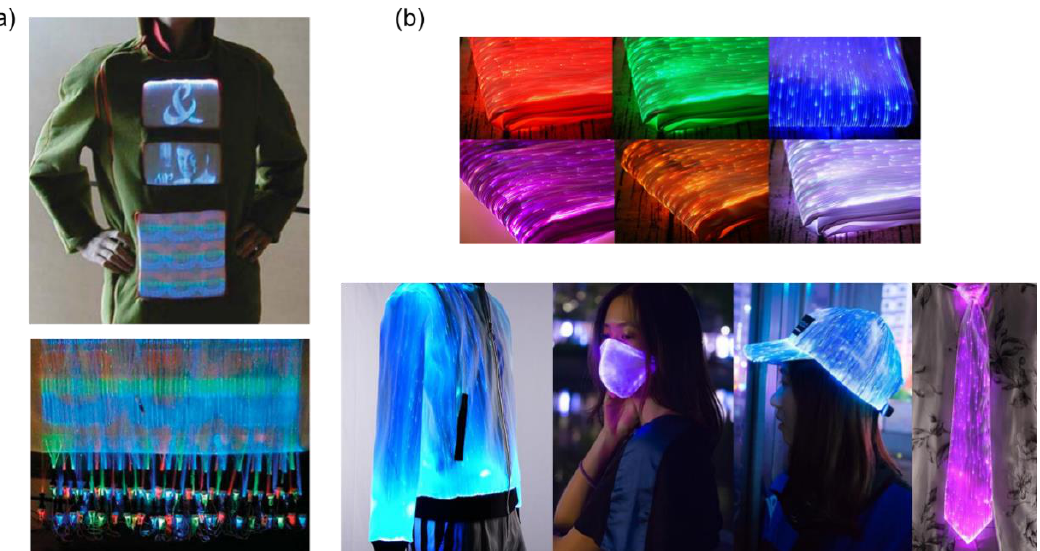
Figure 2. Wearable fiber optic illuminating technology: ( a ) flexible fabric display; [9] ( b ) luminous fiber optic fabrics and sample apparel. [24].